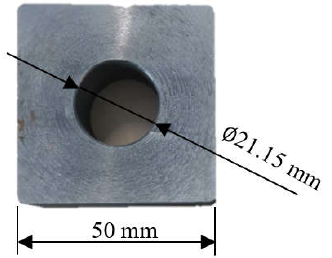
Figure 3. Structure of workpiece.